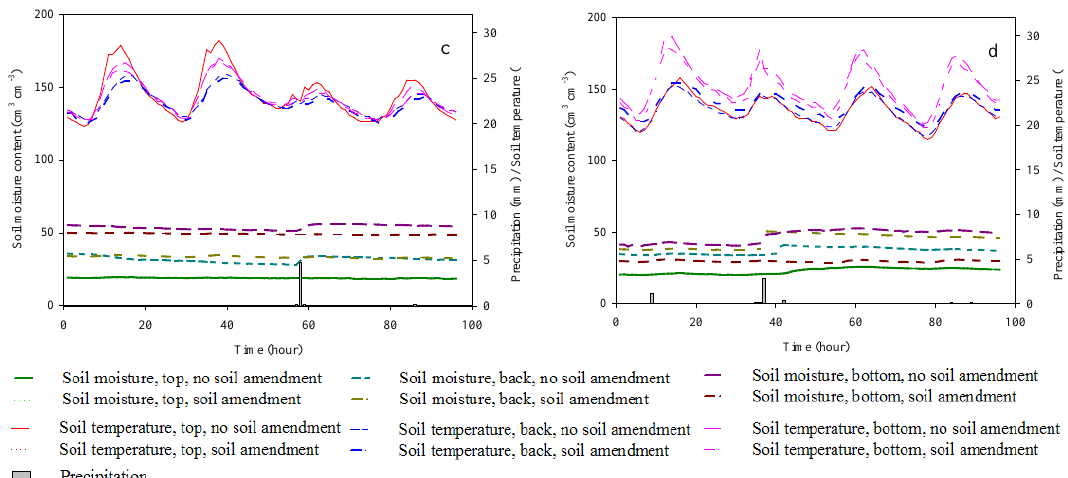
Figure 4. ( a – d ) represent the dynamics of soil temperature and soil moisture during the consecutive